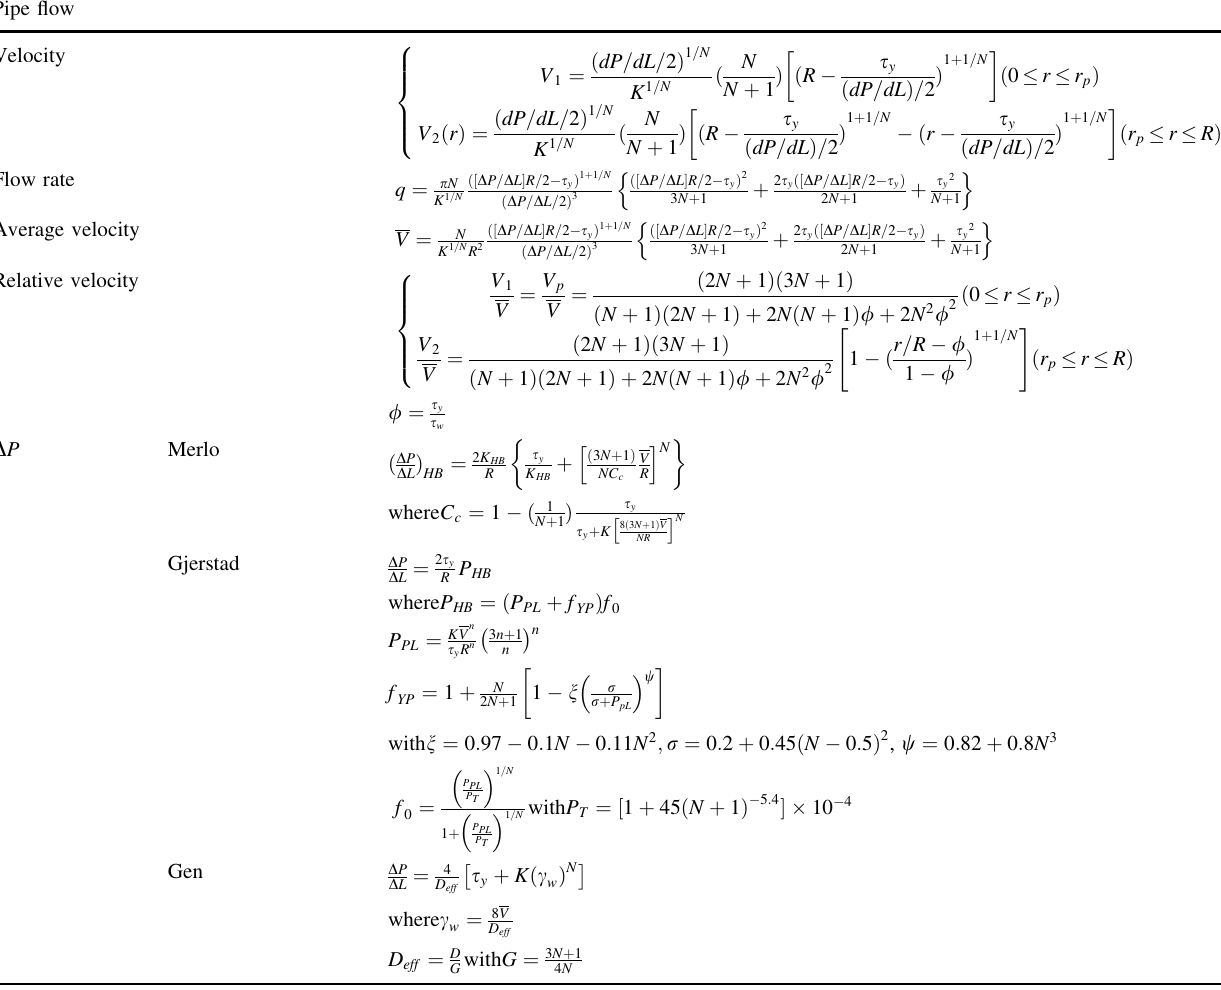
Table 1 Summary of the HB model’s flow equations for pipe flow. It is noted that the abbreviation ‘‘Gen.’’ indicates the ‘‘Generalized Shear Rate Method’’ Pipe